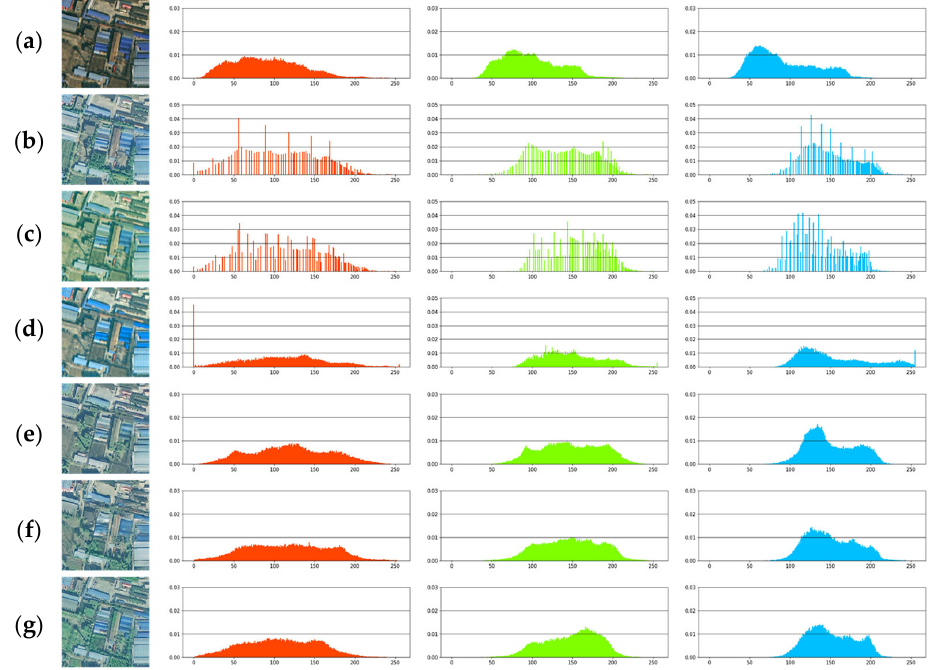
Figure 9. RGB histograms of the image color translation results obtained on the Beijing Huairou district land survey dataset, ( a ) 2018 image, ( b ) 2019 image, ( c ) HM, ( d ) Reinhard method, ( e ) DRIT, ( f ) UNIT, and ( g ) CycleGAN.